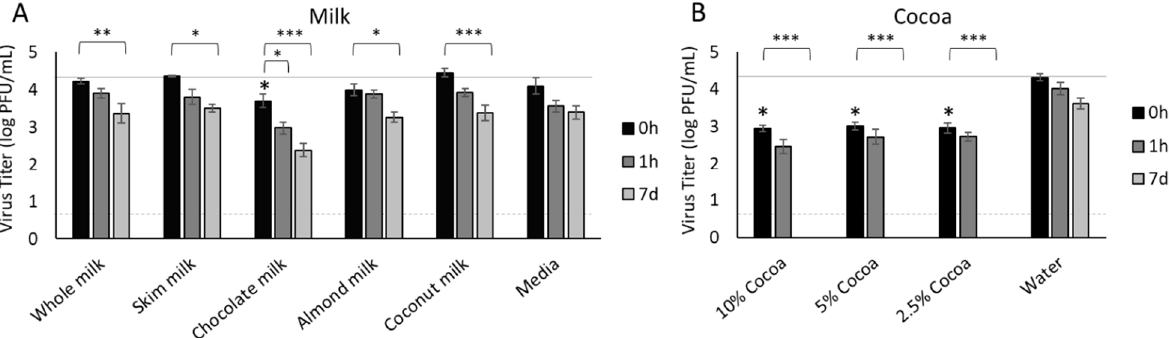
Figure 1. Survival of SARS-CoV-2 in milk and cocoa. SARS-CoV-2 was recovered from bovine- and plant-based milk products ( A ) and different concentrations of cocoa dissolved in water ( B ) immediately after inoculation (0 h) and at 1 h and 24 h after inoculation. Infectious virus was quantified by plaque assay on Vero E6 cells and shown as log PFU/mL. No significant differences were detected between inoculum and 0 h for any of the milk products except chocolate milk ( p = 0.0122). 10%, 5%, and 2.5% cocoa were significantly reduced at 0 h compared with the inoculum ( p < 0.0001). The inoculum is shown as a solid gray line (4.3 log PFU/mL) and the detection limit of the plaque assay is shown as a dashed line (0.7 log PFU/mL). Significant differences between 0 h and inoculum are shown with an asterisk. Significant differences between means at 0 h and later time points are shown by brackets and asterisks (* <0.05; ** <0.01; *** <0.001). Error bars = SEM.